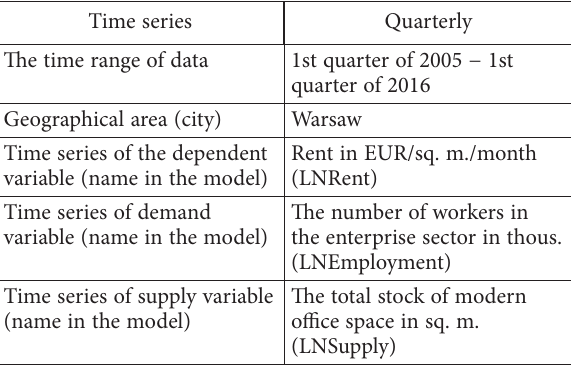
Table 2. Descriptive statistics of time series employed (source: own study) Time series Min. Max. Avg. SD Rent (EUR/sq. m.) Stock (sq.